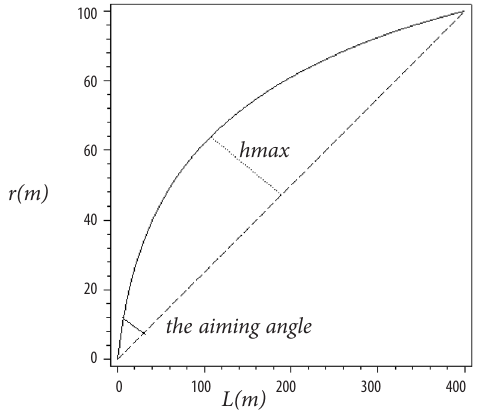
Fig. 4. Path of a bullet fired in a mountainous area (upwards direction). The aiming line is reflected in hyphens. The maximum height of the path (dotted line) h max = 34.5 m , the aiming angle is